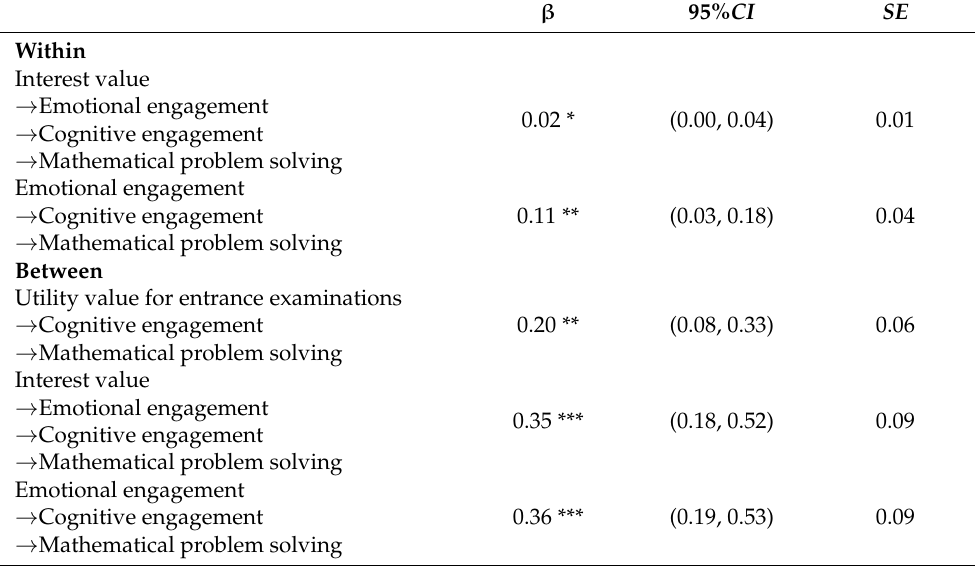
Table 5. Indirect